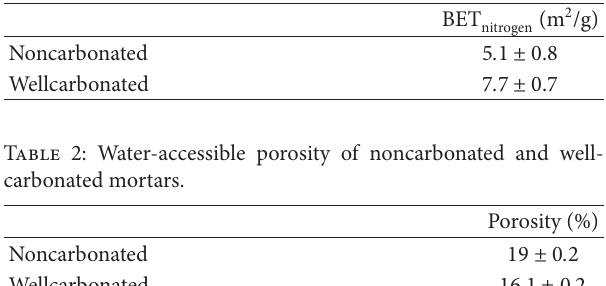
Figure 3: Cumulative pore volume determined by nitrogen adsorp- tion. Table1:Specificsurfaceareaofnoncarbonatedandwell-carbonated mortars.